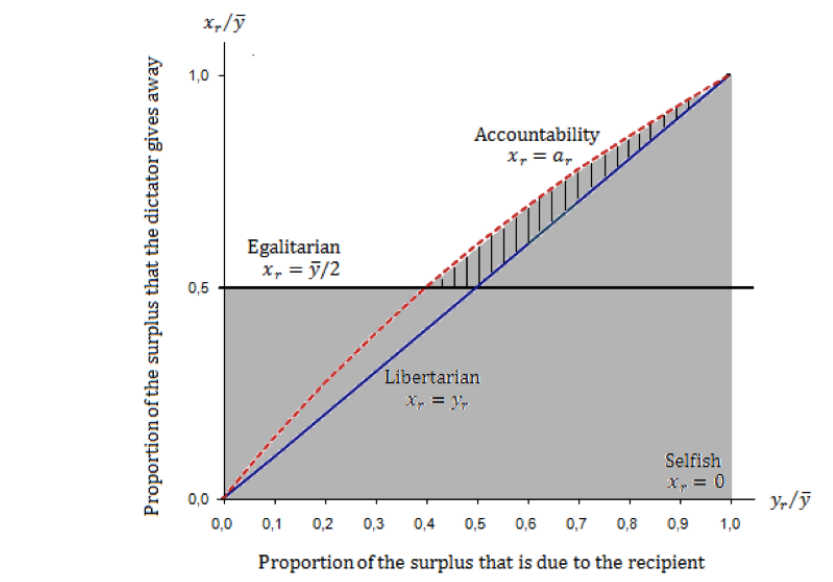
Figure 1. Graphical representation of our predictions if p d > p r